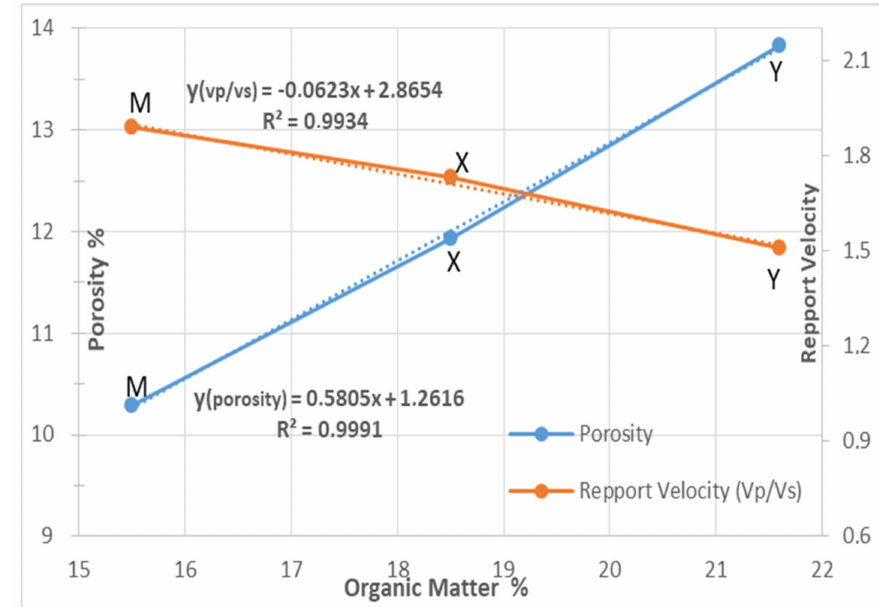
Figure 6. Variations in porosity and velocity as a function of organic